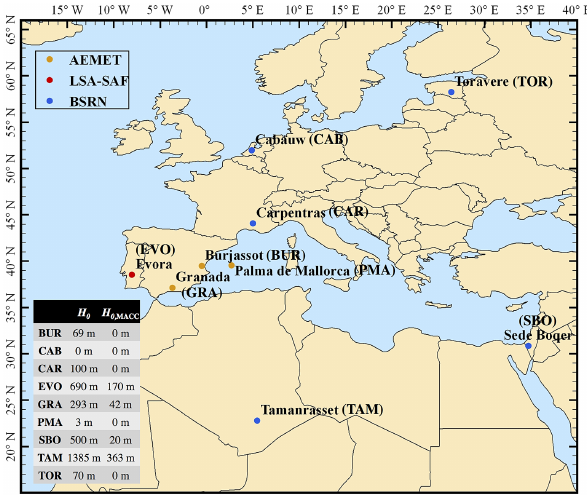
Figure 3. Map of ground stations used in this article. Different colors depict the different radiation networks. The height of each ground station ( H 0 ) and that of the corresponding pixel in the MACC-II grid ( H 0 , MACC ) are given (see Sect.